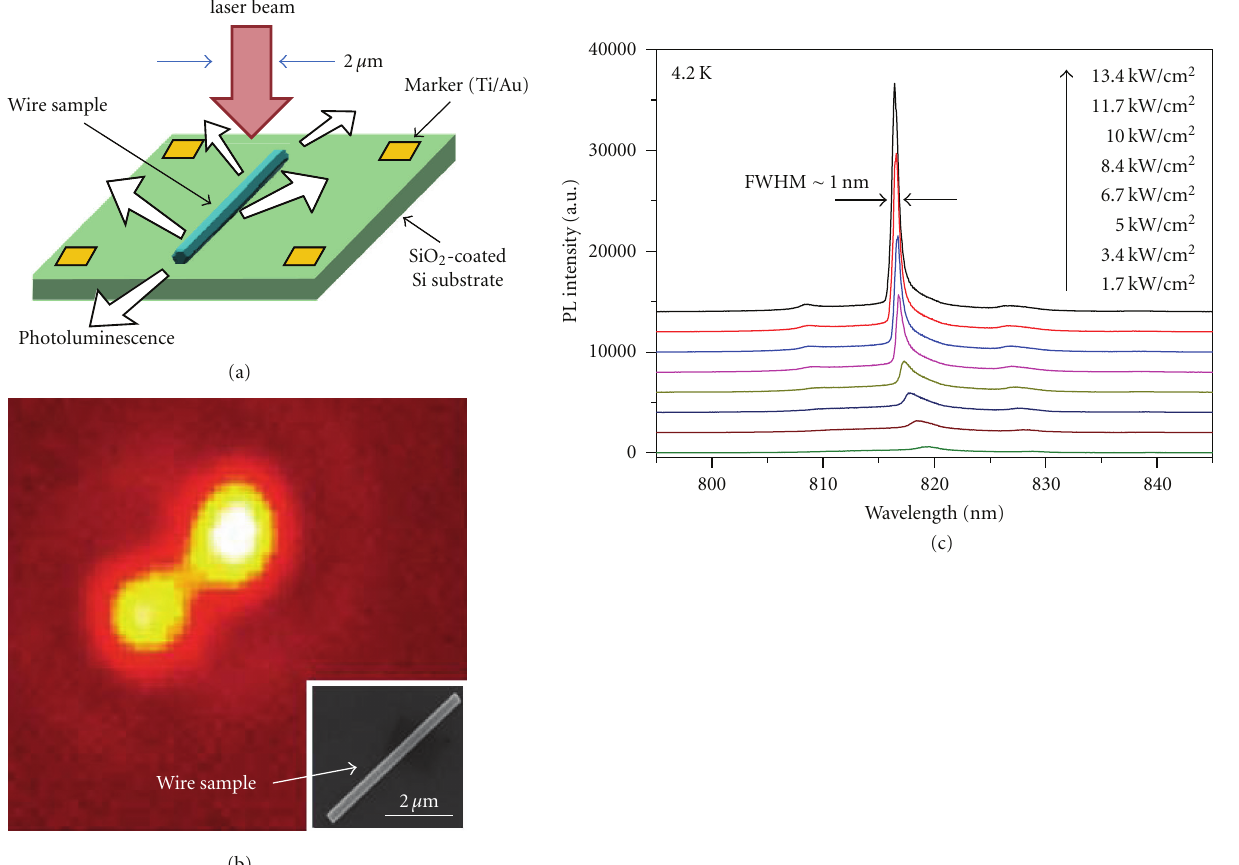
Figure 25: Images of optically pumped single GaAs/GaAsP core-shell nanowire lasers and PL spectra. (a) Schematic of nanowire sample excited by laser beam. (b) CCD camera image of luminescence from nanowire. Inset at bottom right is SEM image of 5.5- μ m-long nanowire. (c) PL spectra from single GaAs/GaAsP core-shell nanowire with length of 5.5 μ m, as function of increasing excitation power density at 4.2K [32].